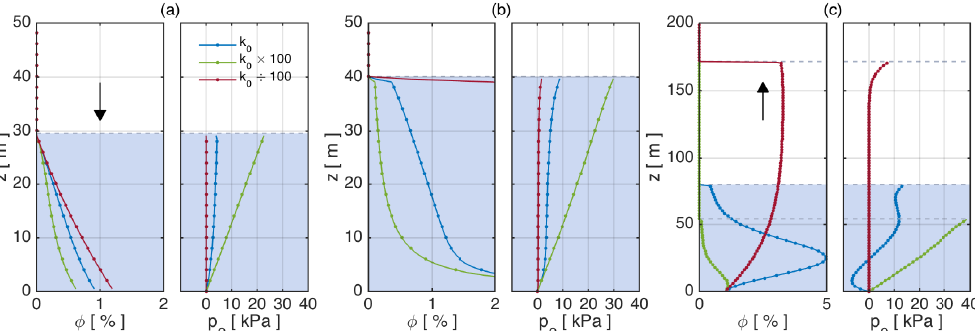
Figure 3. Steady-state solutions for the parallel-sided slab with the compaction pressure model, showing porosity and effective pressure as a function of height. Normal velocities are (a) w = − 0 . 2myr − 1 , (b) w = 0myr − 1 , and (c) w = 0 . 2myr − 1 . In each case blue dots show the same solution as in Fig. 2, purple dots are for permeability 100 times smaller (the porosity then approaches the no-water-flux solution), and green dots are for permeability 100 times larger. For large permeability, the pore pressure is essentially hydrostatic, so the effective pressure is linear, ∂p e /∂z ≈ (ρ w − ρ)g from Eq. (14).